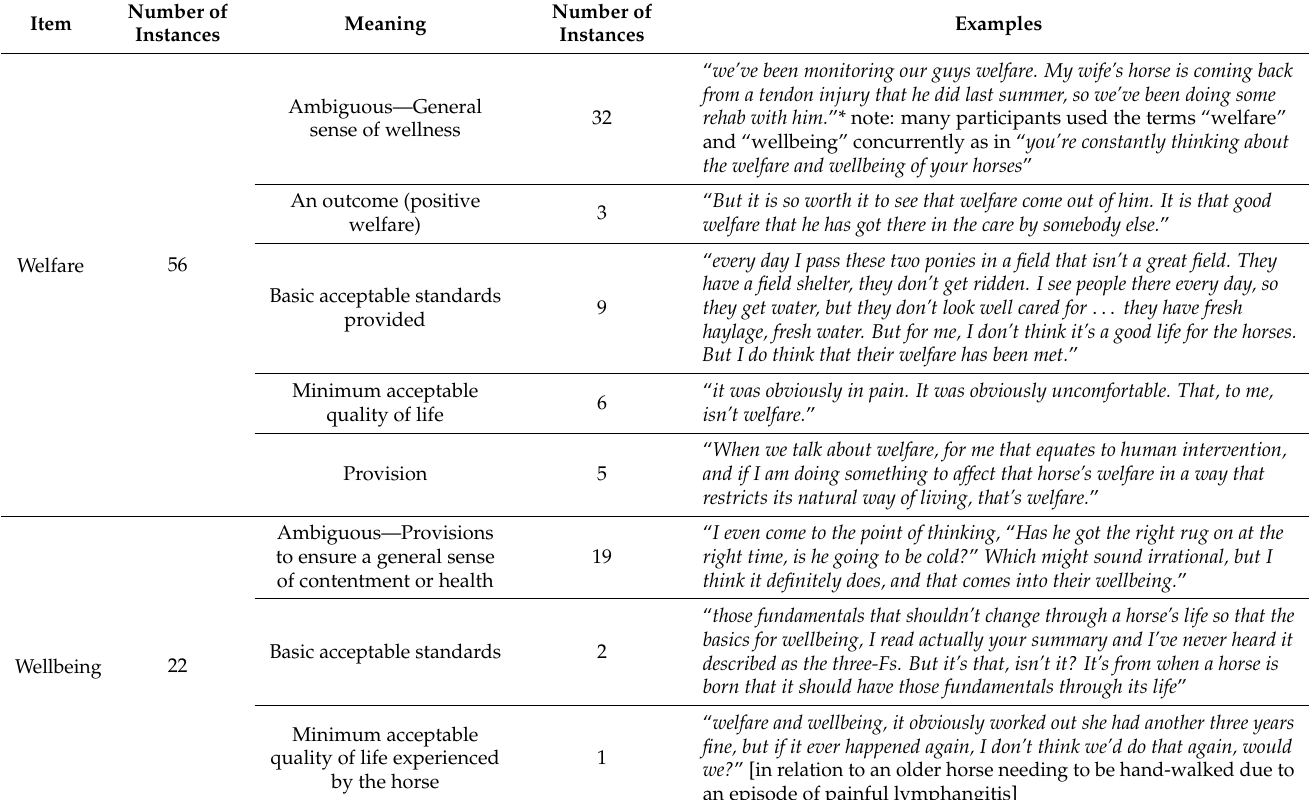
Table 2. Results of a content analysis of the terms of